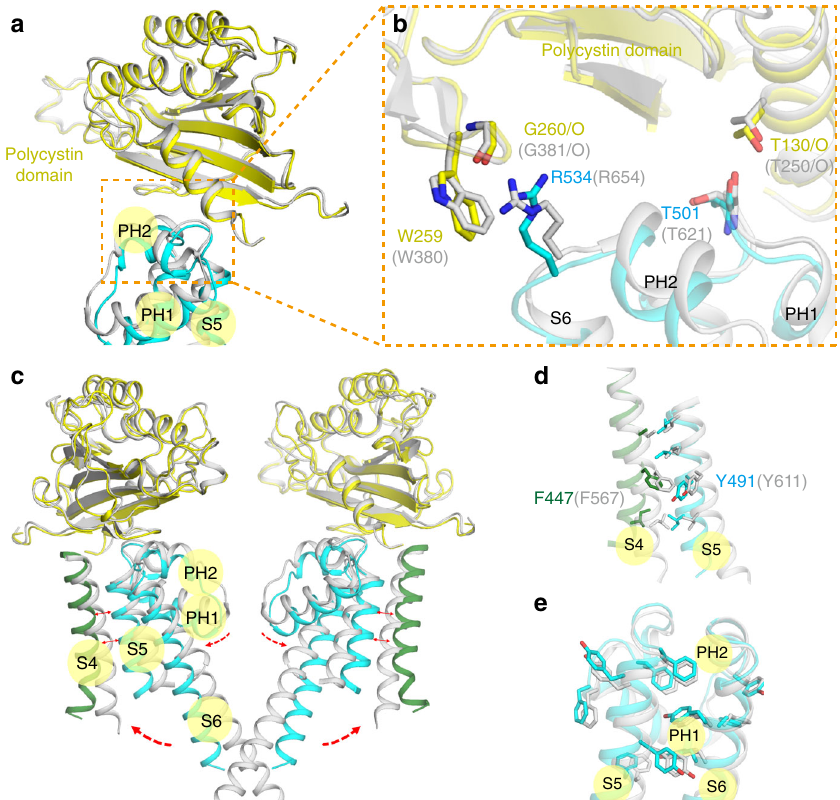
Fig. 5 Interactions between pore domains and neighboring domains modeled in PKD2L1. a The upper gate is persistently close to the polycystin domain in both closed and open states. For visual clarity, only one diagonal protomer is shown. The polycystin domain (yellow represents PKD2L1 and gray for its homologous closed-state model) placed on top is from an adjacent protomer, depicting a close interaction with the pore domain. b The polycystin domain and the pore interact at two pivots, R534/W259 and T501/T130, around which the whole structure of the pore could swing forward and back. c The conformational changes pertaining to the pore regions (S5-PH-S6) between the PKD2L1 structure (cyan) and the homologous model (based on the PKD2 structure) representing its closed state (gray). For visual clarity, only two diagonal protomers are shown. The polycystin domains (yellow in the PKD2L1 structure and gray in the homologous model) placed on top and the S4 helix are from adjacent protomers, ensuring a close interaction with these pore domains, as shown in d . The red dotted arrows indicate regional shifts of the pore domain from a closed to open state. Reciprocal arrows between S4 and S5 are explained as in panel d . d Interactions between the S4 helix and an adjoining S5 helix guarantee that S5 sways together with S4 in the same direction. e Numerous aromatic residues may restrict the dynamics of each pore helix and maintain the related structure as a rigid